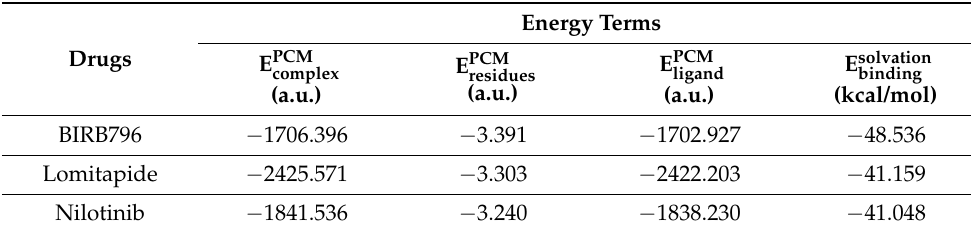
Table 2. Calculated binding energy (E solvation ) in kcal/mol of two screened drugs and BIRB796 by binding means of ONIOM at B3LYP/6-31G(d):PM6 level of theory. Energy Terms Drugs E PCM E PCM E solvation E PCM ligand complex binding residues (a.u.) (a.u.) (a.u.) (kcal/mol) BIRB796 − 1706.396 − 3.391 − 1702.927 − 48.536 Lomitapide − 2425.571 − 3.303 − 2422.203 − 41.159 Nilotinib − 1841.536 − 3.240 − 1838.230 −